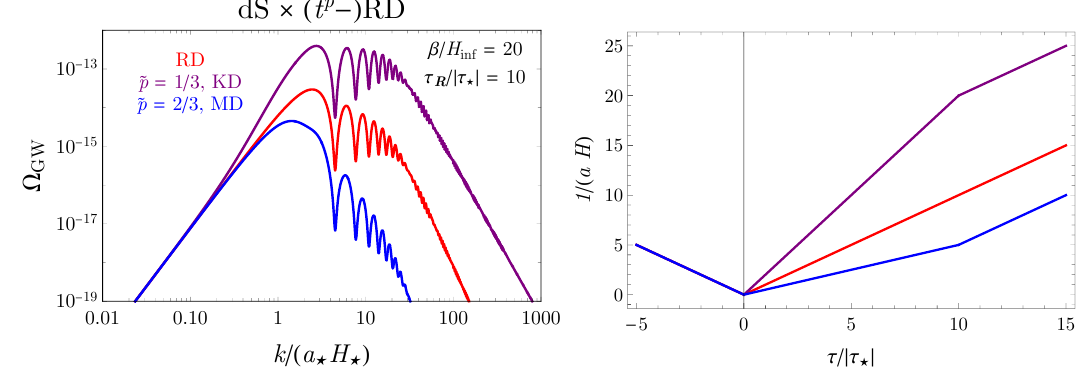
Figure 7 . Left: GW spectrum from first-order phase transition during the quasi-de Sitter inflation, in scenarios with a t ˜ p intermediate stage before the RD era and the inflation. The blue and purple curves are for MD and KD intermediate stages, respectively. As a comparison, the GW spectrum for the instantaneous reheating scenario is also shown as the red curve. For all the three scenarios τ R is fixed to be 10 | τ ? | . Right: the evolution of 1 / ( aH ) for the scenarios shown in the left